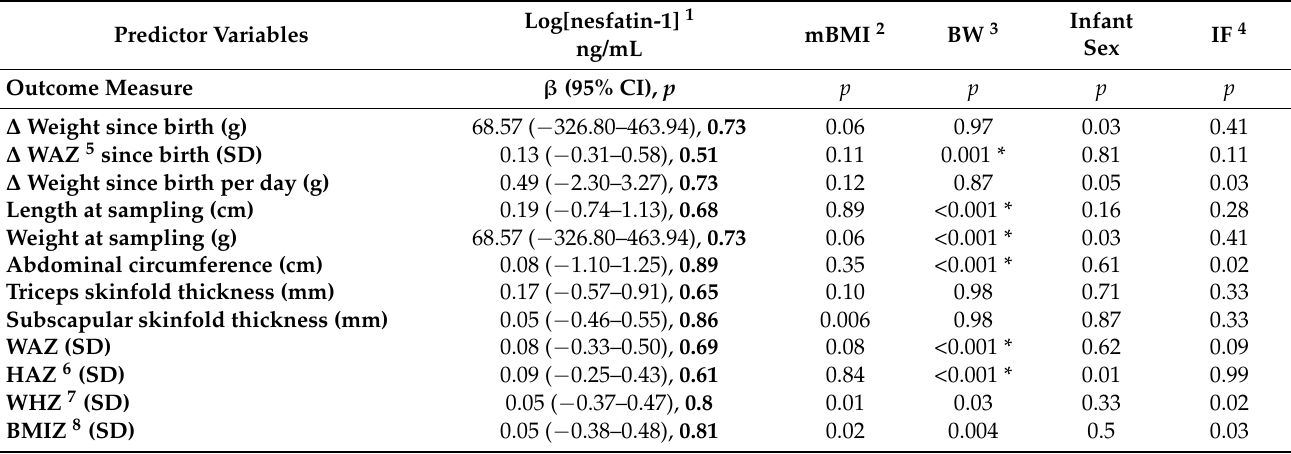
Table 2. Multivariate linear regressions for anthropometrical measures and growth outcome.